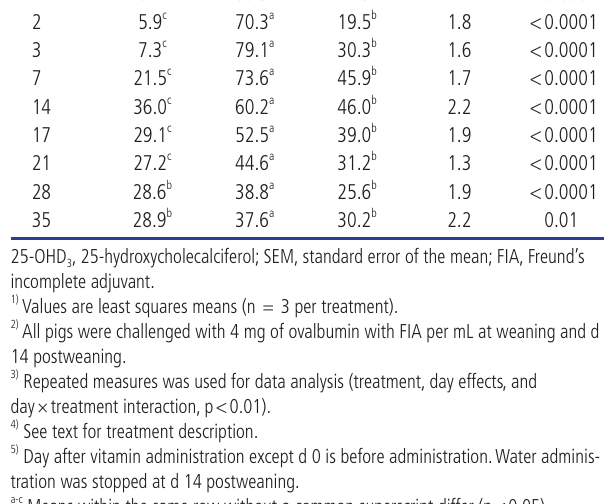
Table 3. Growth performance of pigs with vitamin D drinking water with or without vitamin A, D Item